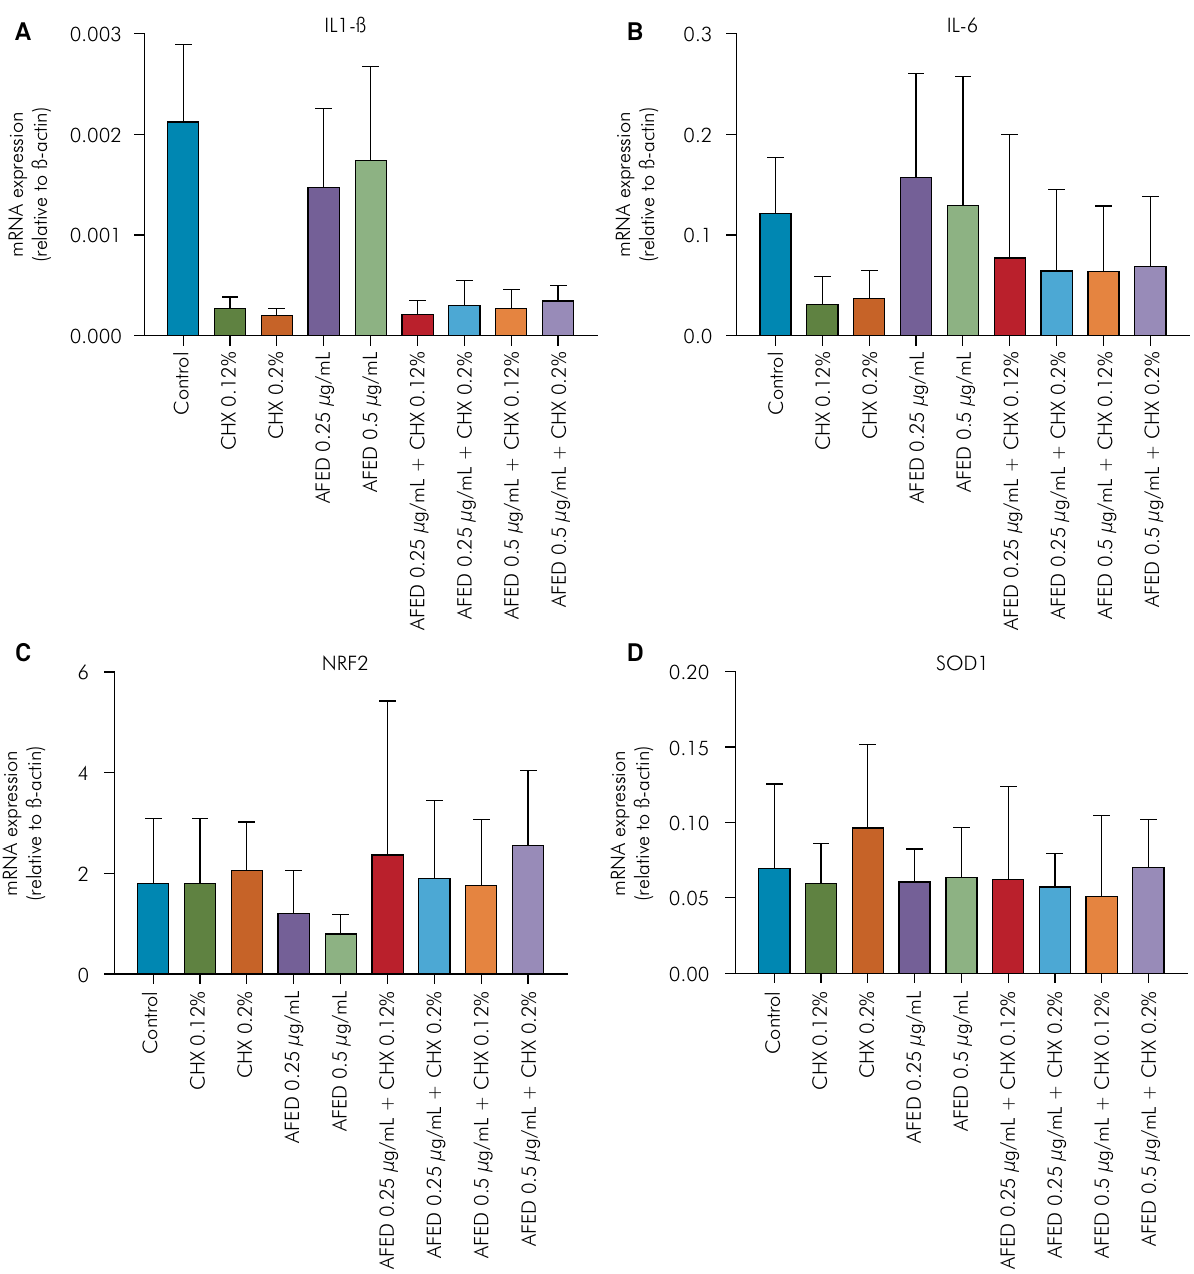
Figure 5. Effect of acetone fraction of Eugenia dysenterica (AFED) in relative mRNA expression in inflammatory and oxidative stress-related genes in gingival fibroblast cells (GFC) after chlorhexidine (CHX) treatment. Cells treated for 24 h and qPCR performed to verify interleukin 1 beta (IL1b) (A), interleukin-6 (IL6) (B), nuclear factor erythroid 2-related factor 2 (NRF2) (C), and superoxide dismutase 1 (SOD1) (D) expression. There was no statistical difference between the